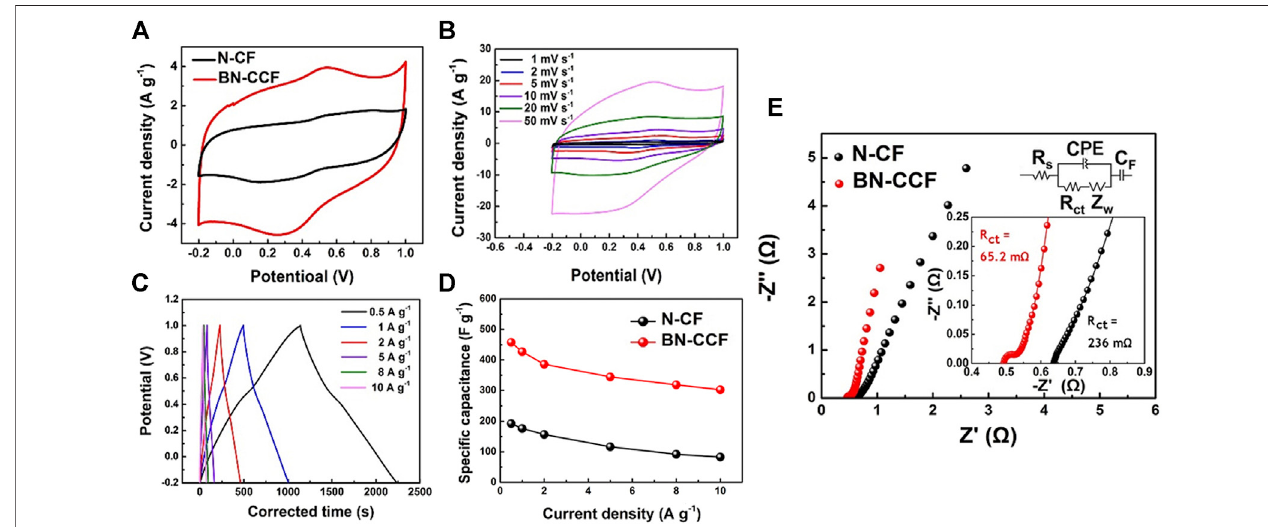
FIGURE6| ElectrochemicalperformancesofN-CFandBN-CCF: (A) CV(10 mV s − 1 )and (B) GCD(1 – 10 A g − 1 )curvesofN-CFandBN-CCF (C) CV(1 – 50 mV s − 1 ) and (D) GCD (0.5 – 10 A g − 1 ) curves of BN-CCF (E) Corresponding equivalent circuit model and Nyquist plots of N-CF and BN-CCF.